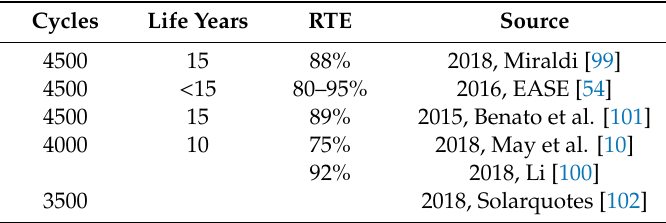
Table 21. Cycles, life years, and RTE—sodium-metal halide technology. Cycles Life Years RTE